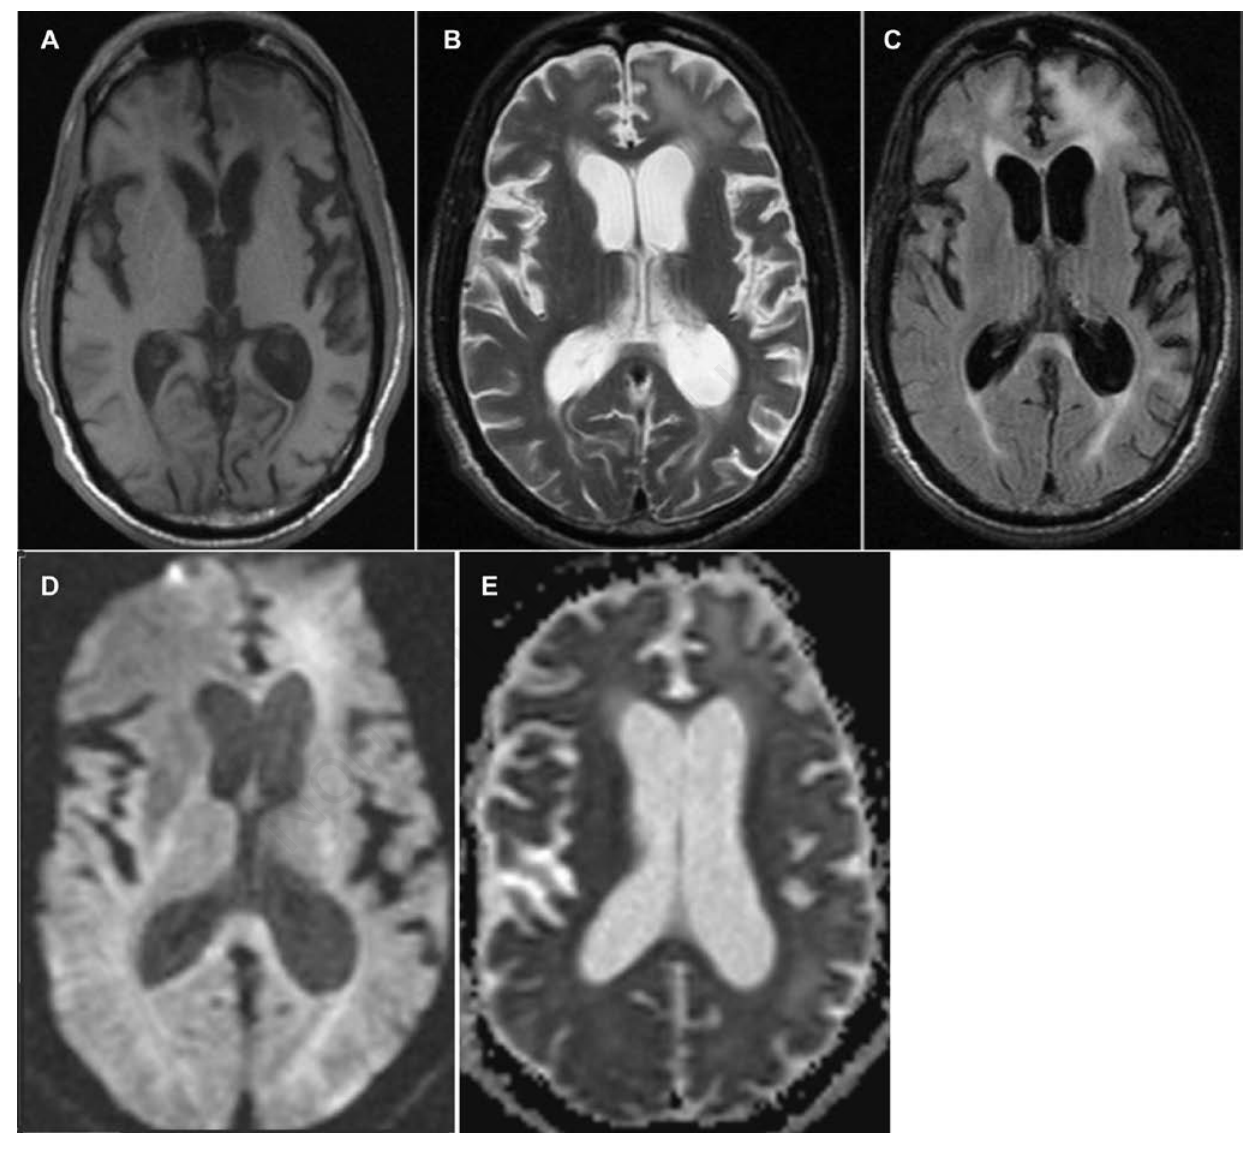
Figure 2. A) Axial T1 weighted magnetic resonance imaging (MRI) brain with temporal lobe atrophy and subcortical hypointensities in the right and left frontal regions; B) axial T2 weighted MRI brain showing dilated lateral ventricles out of proportion to the degree of cerebral atrophy, associated with hyperintensities in the left frontal subcortical region, the left parieto-occipital subcortical region, and to a lesser extent the periventricular region of the anterior horn of the right lateral ventricle; C) axial T2 FLAIR MRI brain showing bifrontal and periventricular hyperintensities; D) axial diffusion-weighted imaging MRI brain showing restricted diffusion in the left subcortical frontal lobe; E) axial apparent diffusion coefficient MRI brain showing diffuse hyperintensities in bifrontal region (left greater than